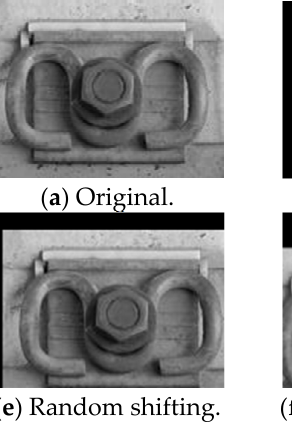
Figure 2. Image data enhancement with different enhanced methods.